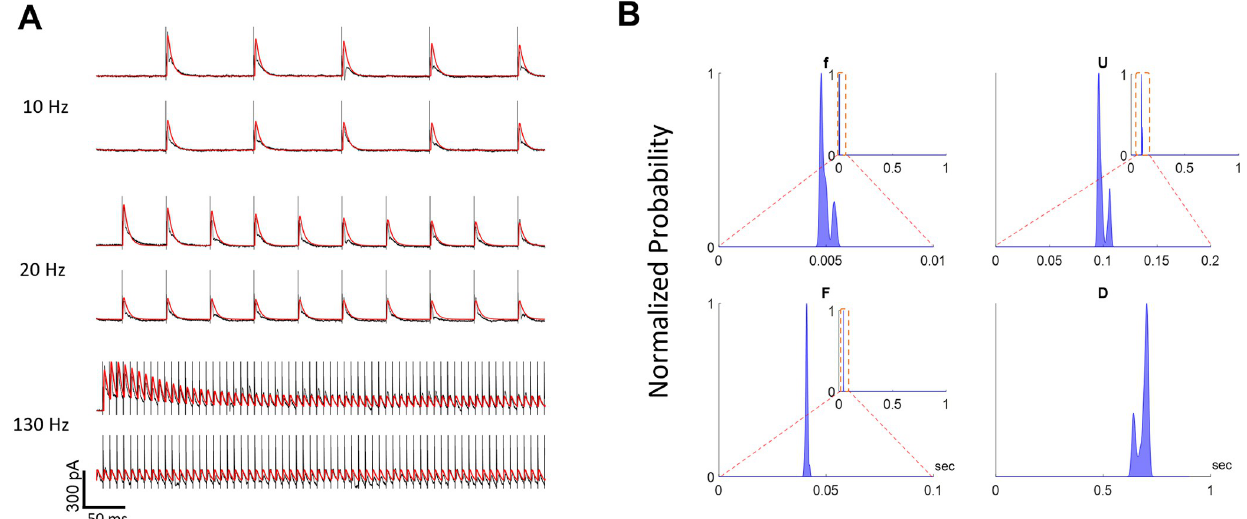
Fig 8. Inferring the model parameters from the experimental data. (A) The output generated by the estimated parameters perfectly fitted the experimental data. (B) Distribution of the estimated parameters by 100 trials of the dual optimization approach with different initial guesses. The estimated parameters are low variance which shows the confidence of the